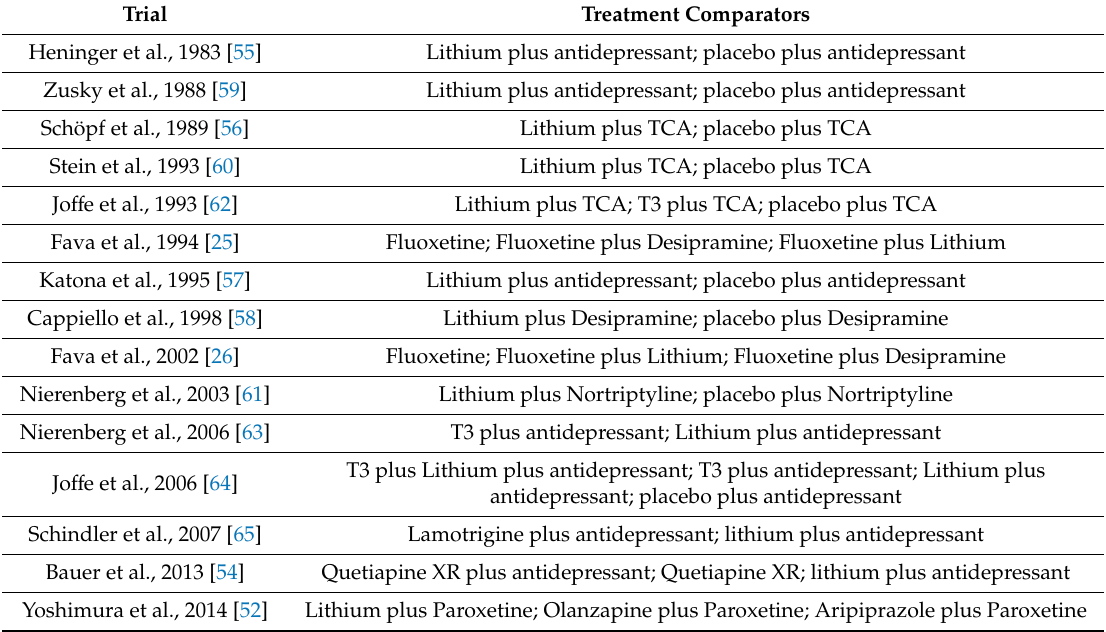
Table 6. List of Included Lithium